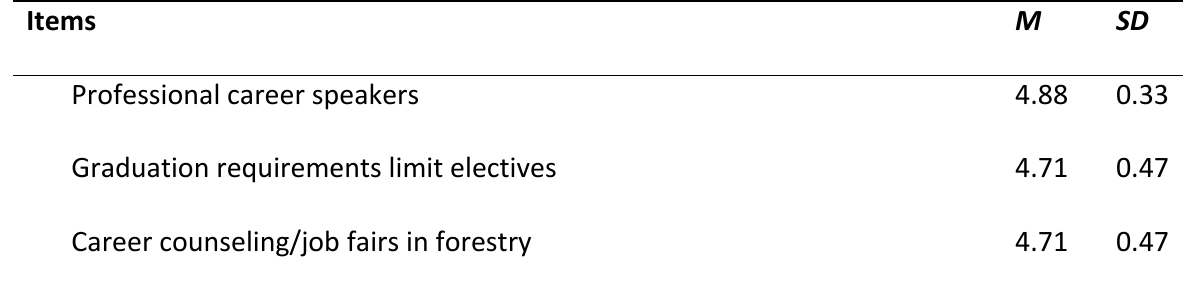
Round 2 – Levels of Agreement: Professional Development Needs in Forestry and Forest Ecosystems (Session